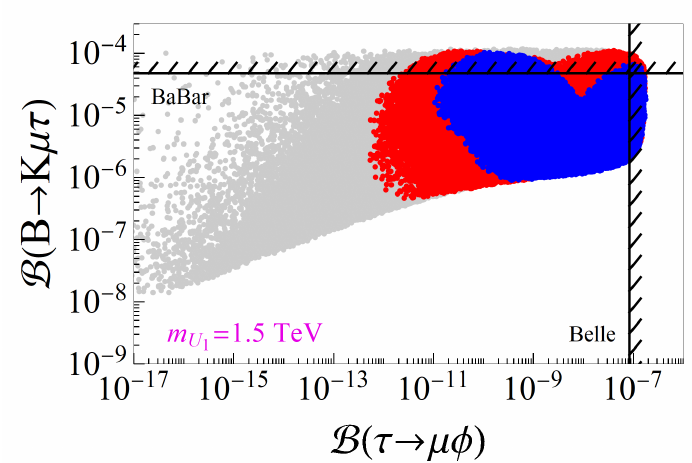
( τ → µφ ) for the U model. Color code is 1 B